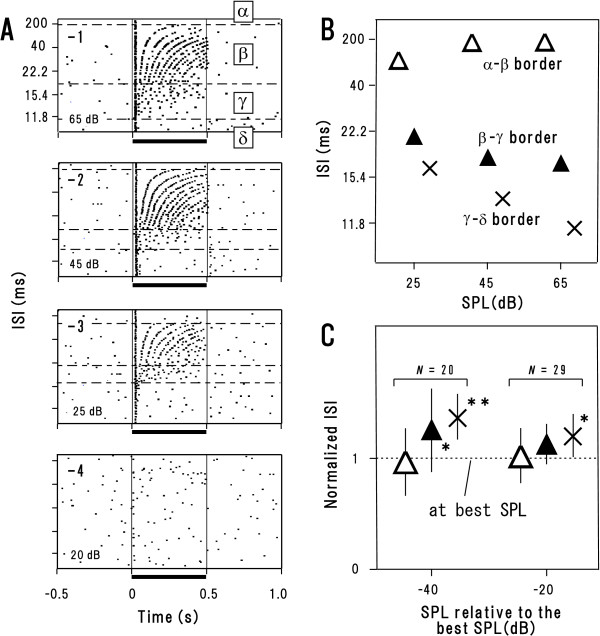
Effects of the stimulus level on the synchronization neurons. Responses of a representative neuron (A, B) and population data (mean ± SD) (C). A-1 to -4: Raster dot of spike occurrence at the best SPL (-1; in pe-SPL), 20 dB below (-2), 40 dB below (-3) and 45 dB below it (-4) (in the same format as Fig. 1A-1). B: The boundaries between the regions found in A-1 to -3 are plotted at each SPL. C: The population data for the same response variables as in B. The values were normalized to those measured at the best SPL (dotted line). *P < 0.05, **P < 0.01 (Fisher's PLSD test following one-way repeated ANOVA).